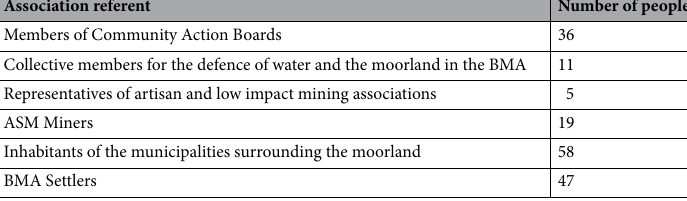
Table 2. Sample according to association referent and the number of